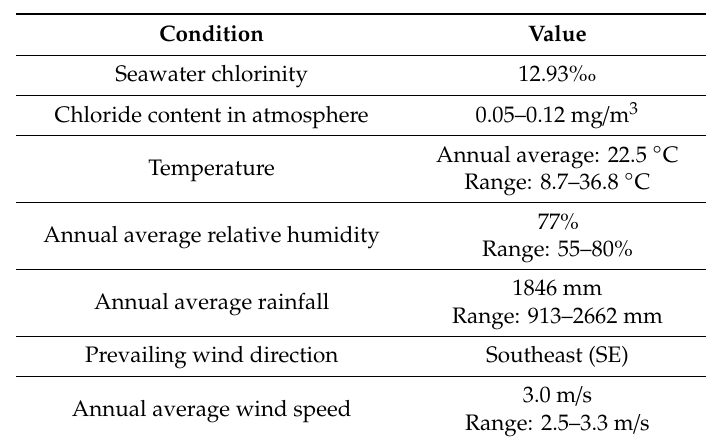
Table 1. Environmental